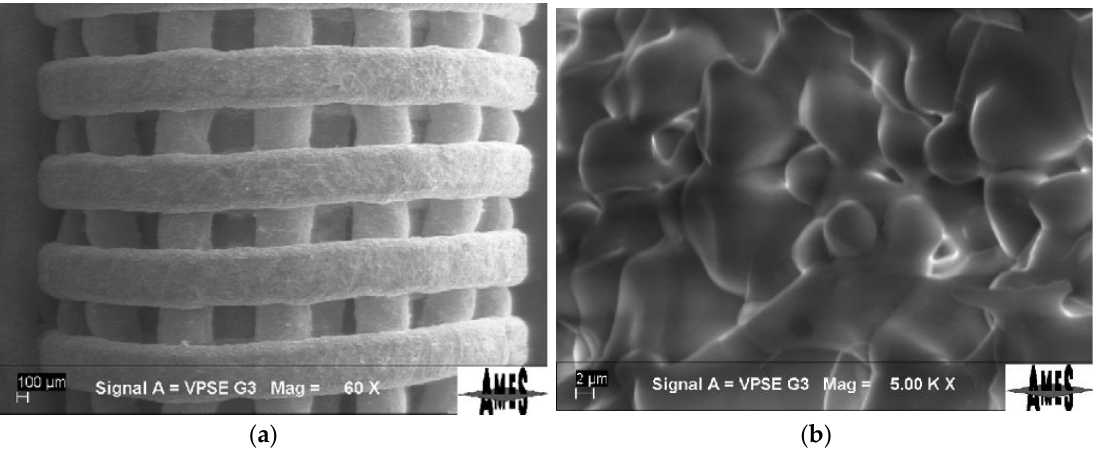
Figure 5. Morphological investigation of a sample prepared for implantation: ( a ) SEM image acquired at low magnification (60×); ( b ) SEM image acquired at high magnification (5000×).